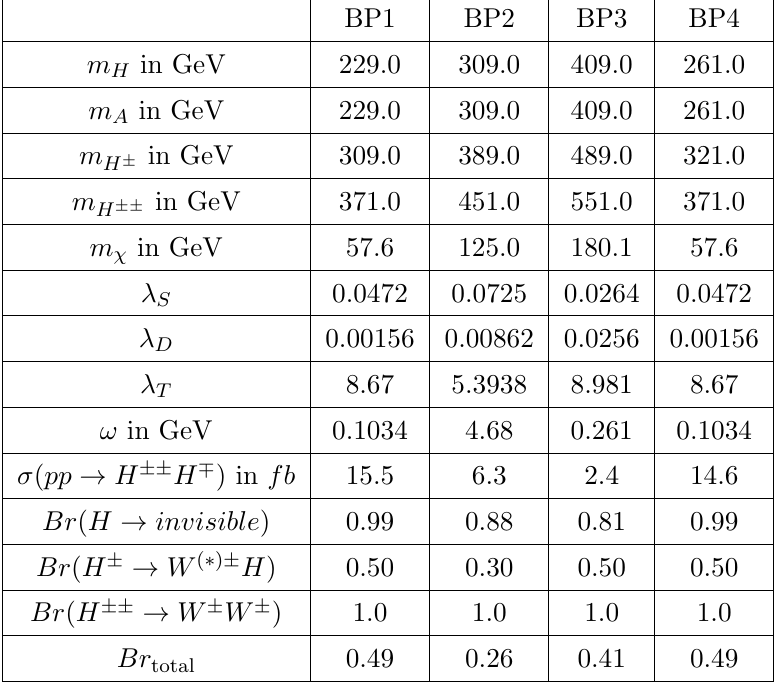
Table 2 . The Benchmark points for same-sign W